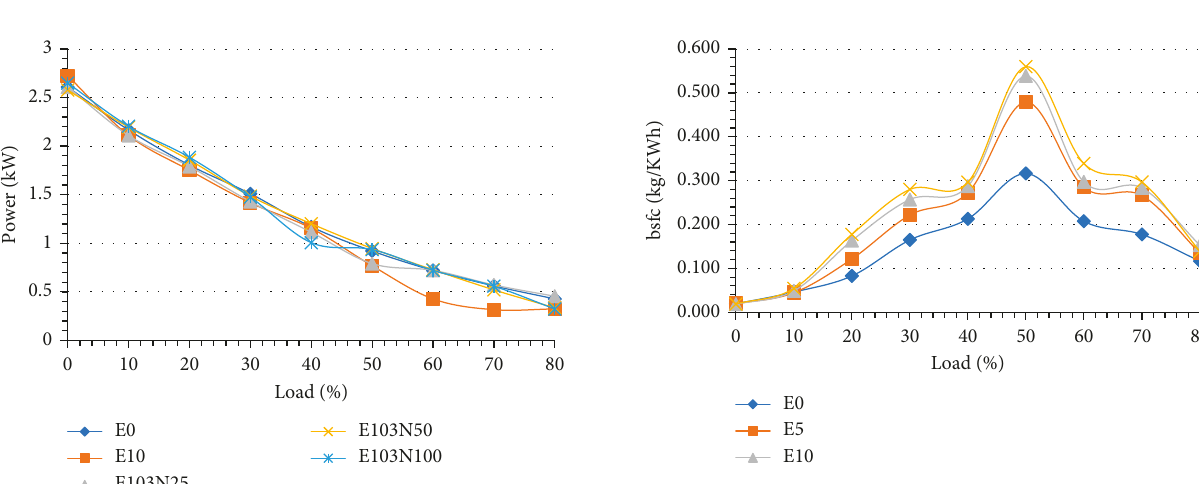
Figure 10: The effect of 3 elemental nanoparticles in E5 on engine power.